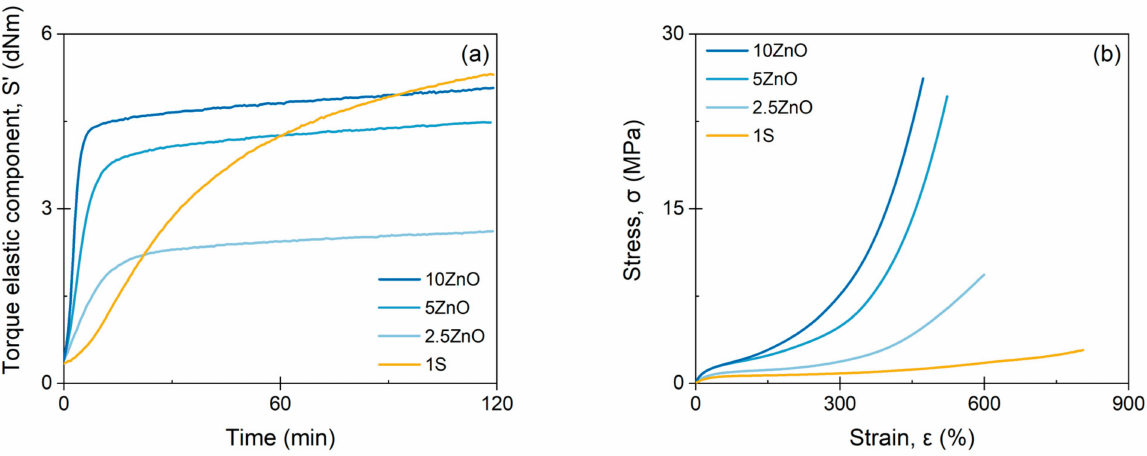
Figure 1. ( a ) Curing curves and ( b ) stress–strain curves of ionic and covalent